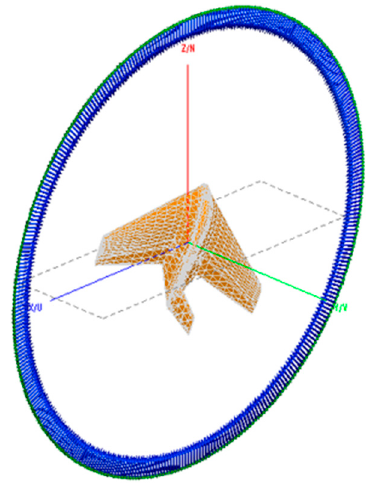
Figure 11. Target geometry of the B-2 stealth CAD model.